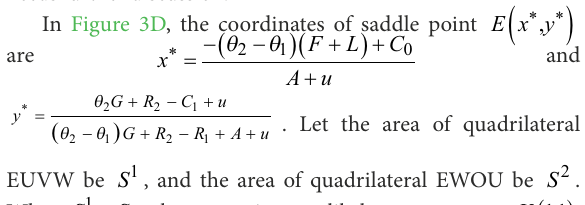
In Figure 3D, the coordinates of saddle point E x y ∗ ∗